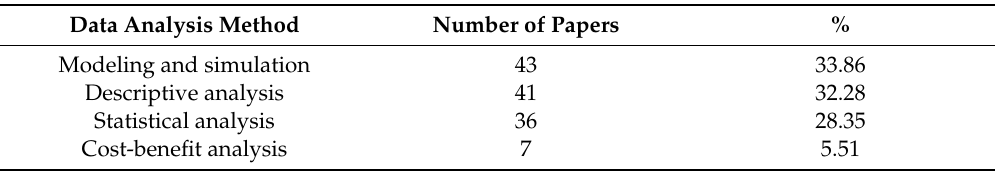
Table 2. Data analysis methods in the sample